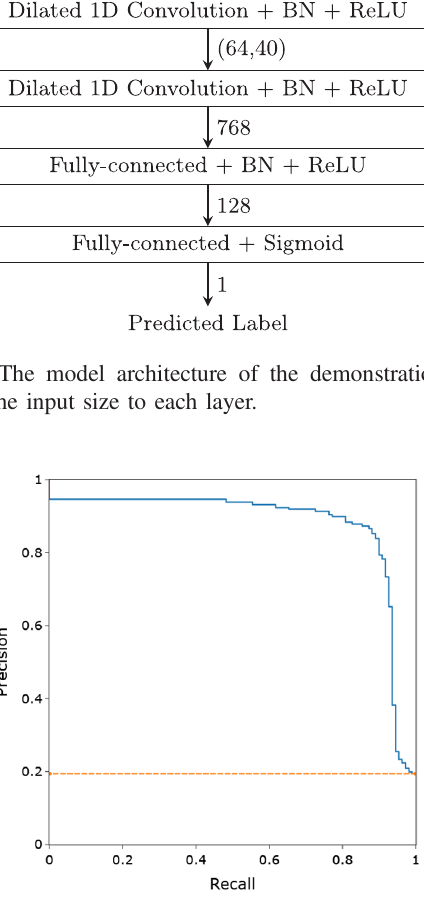
FIG. 9. Interpolated precision-recall curve for the DNN clas- sifier on our new rf station anomaly dataset. The dashed line is the precision-recall curve for a random